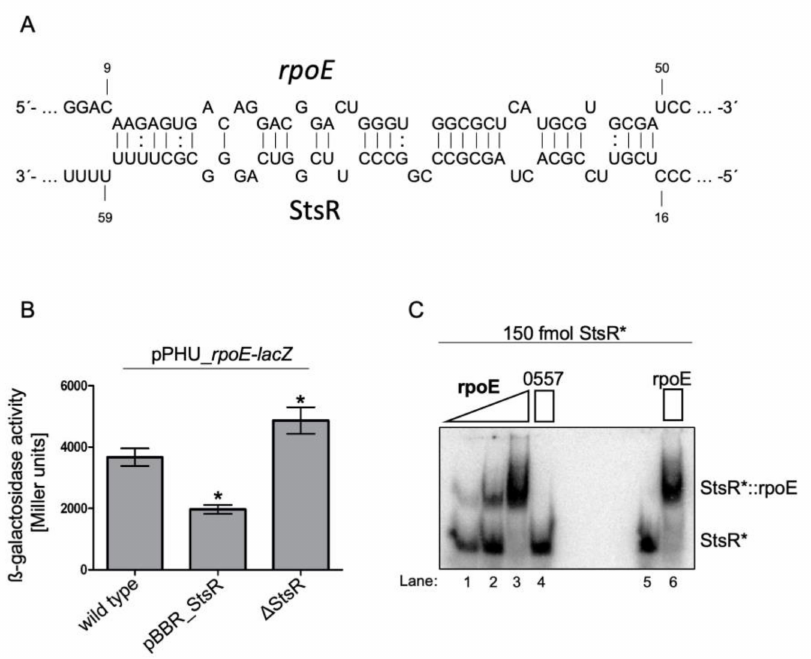
Figure 6. StsR interacts with the rpoE mRNA. ( A ) Seed region for the interaction between rpoE and StsR as predicted by the IntaRNA tool. ( B ) lacZ- based in vivo reporter assay. All strains contain a plasmid with a rpoE-lacZ fusion. While over-expression of StsR reduces rpoE-lacZ activity, lack of StsR leads to higher expression. ( C ) Gel retardation assay showing the interaction of rpoE and StsR in vitro. Radio-labelled StsR (150 fmol) in vitro transcript was incubated with increasing amounts of a 150 nt rpoE in vitro transcript (150–15,000 fmol lanes 1–3). A negative control StsR was incubated together with a 100-fold molar excess of an RSP_0557 [23] in vitro transcript (lane 4). As further controls, the StsR transcript was loaded alone (lane 5) or after de and renaturation together with a 100-fold molar excess of the rpoE transcript. * p <